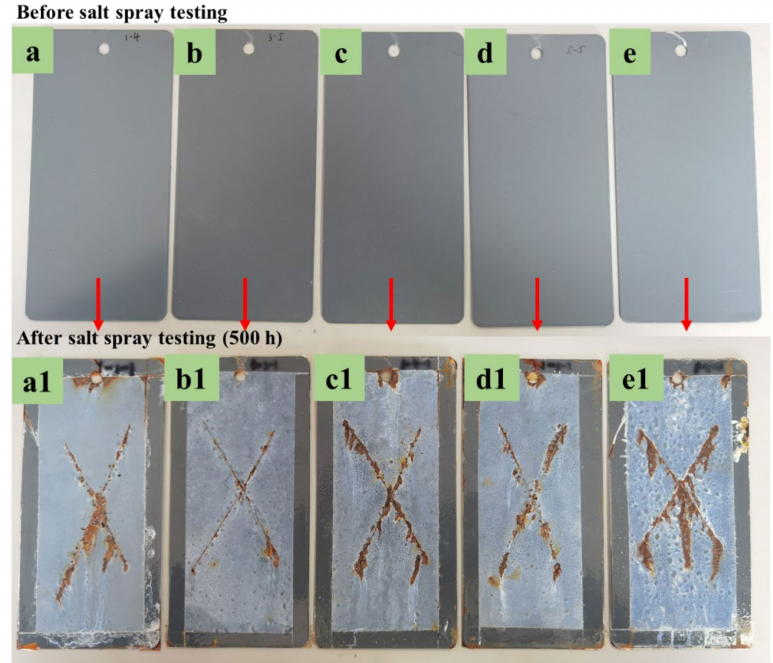
Figure 4. Surface appearance of ZRP coatings: ( a , a1 ) 80% Zn; ( b , b1 ) 4% PPy/SCP-60% Zn (1:5); ( c , c1 ) 6% PPy/SCP-60% Zn (1:3.3); ( d , d1 ) 8% PPy/SCP-60% Zn (1:2.5); ( e , e1 ) 12% PPy/SCP-50% Zn (1:2.5) before and after exposing to salt spray fog with 5% NaCl for 500 h, respectively. The line roughness of ZRP coatings with different content of zinc dusts and PPy/SCP particles before and after 500 h of exposure to salt spray is shown in Figure 5. It can be seen